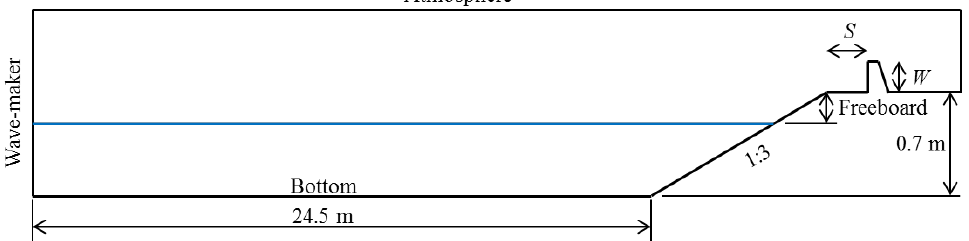
Figure 10. Maximum and minimum wave height envelopes and mean water level in the plunging